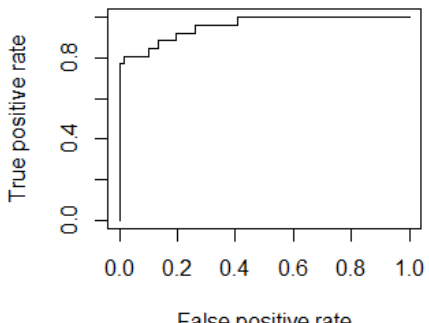
Figure 7. ROC curve of the neglect